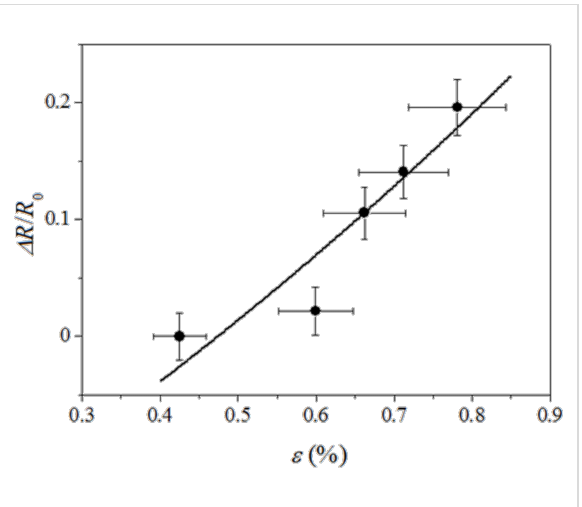
Figure 9: Dependence of the normalized electric resistance variation Δ R / R 0 on strain ε . The bars indicate the relative measurement error estimated at 1% and 8% for ε and Δ R / R 0 , respectively. The solid line shows the best fit to the experimental data as calculated from the theo- retical prediction given by Equation 3 with τ = 53 ±